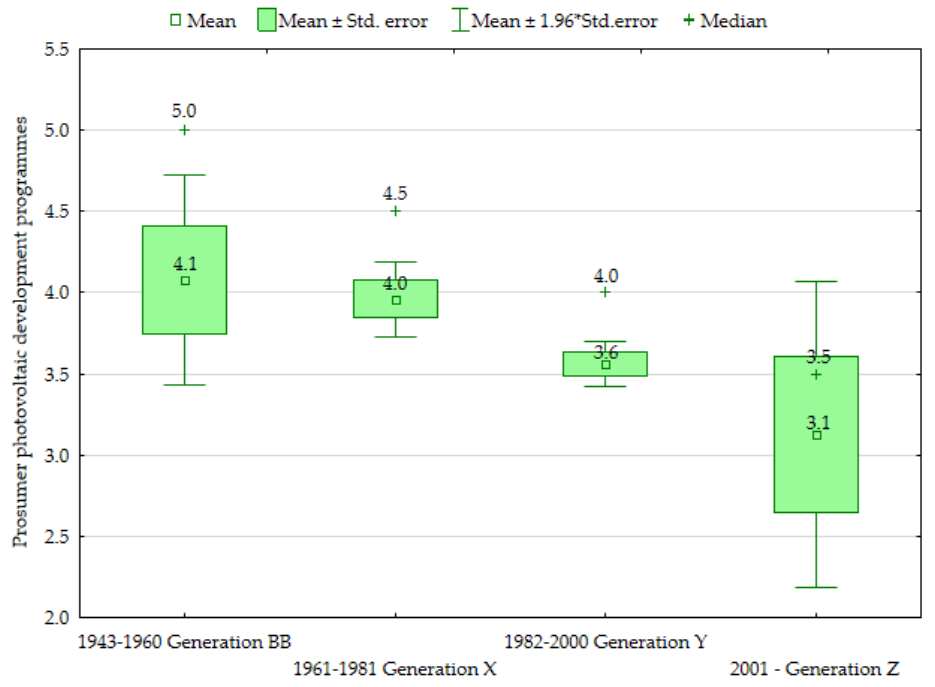
Figure 5. Age of respondents and their assessment of the prosumer photovoltaic development pro- gramme. Source: Own study based on the conducted research. n = 444. programme. Source: Own study based on the conducted research. n =